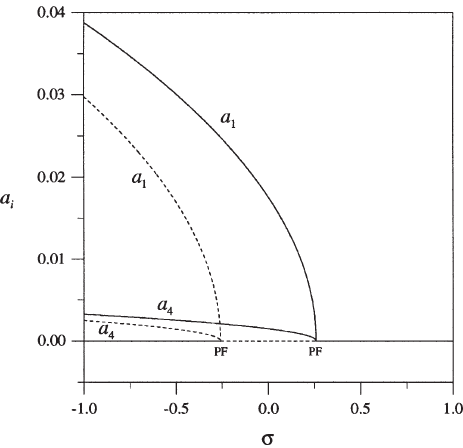
Fig. 4. Frequency-response curves for a combination parametric res- onance of the additive type involving modes 1 and 4 for f = 10, (cid:22) 1 = 0 : 0137, (cid:22) 4 = 0 : 0573. Solid lines (—) denote stable fixed points and dashed lines (– – –) denote unstable fixed